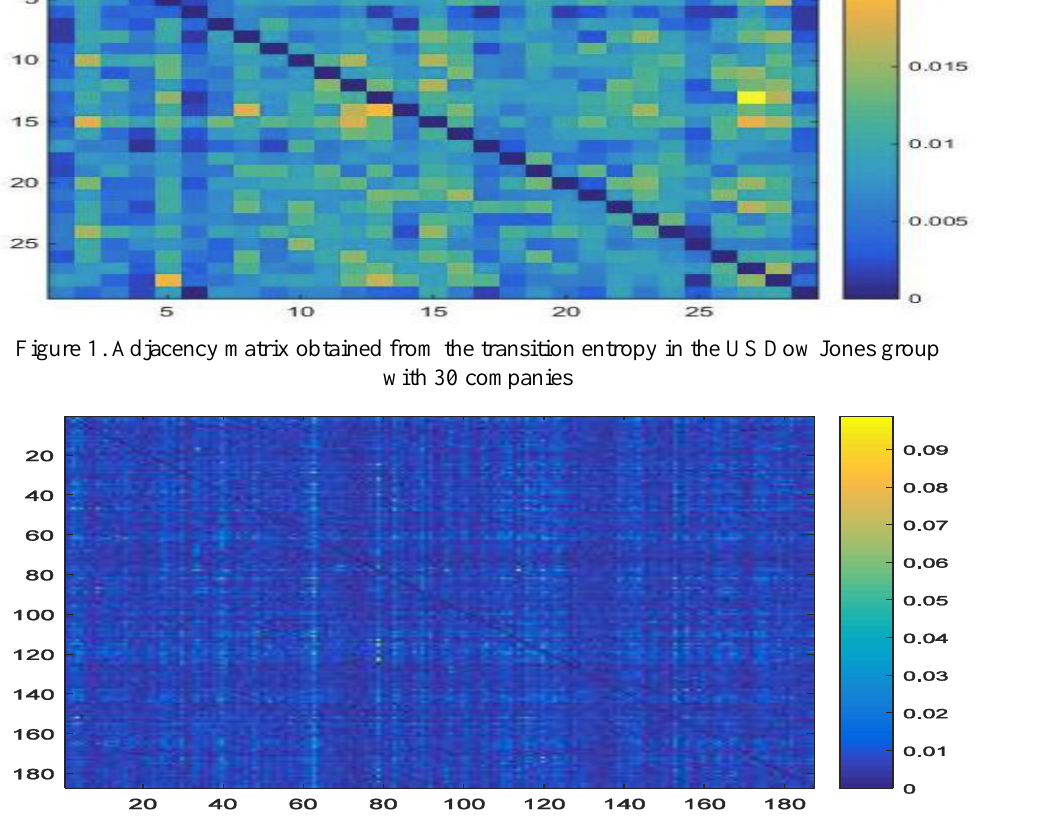
Figure 2. Adjacency matrix obtained from transfer entropy in Tehran Stock